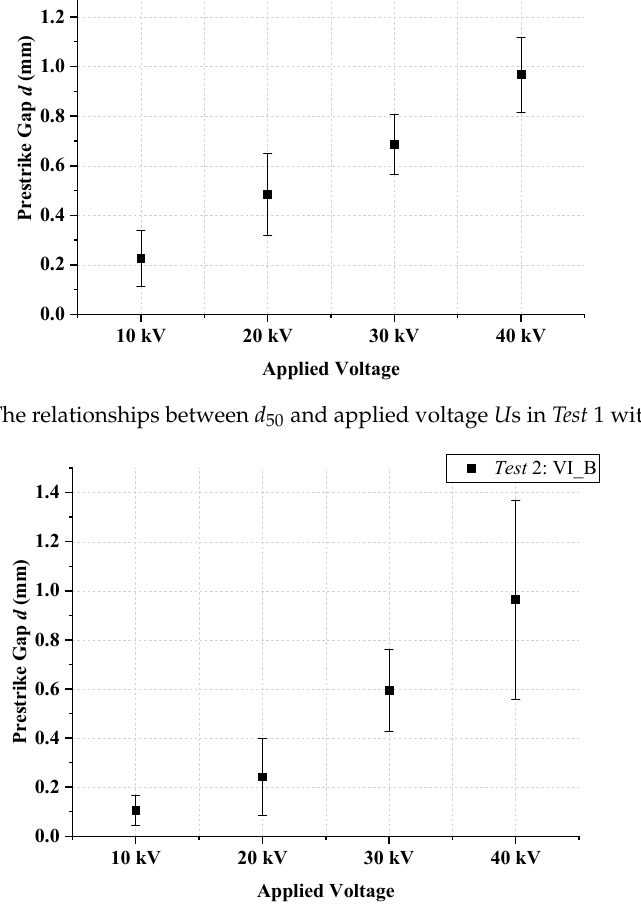
Figure 8. The relationships between d 50 and applied voltage U s in Test 2 with VI_B.